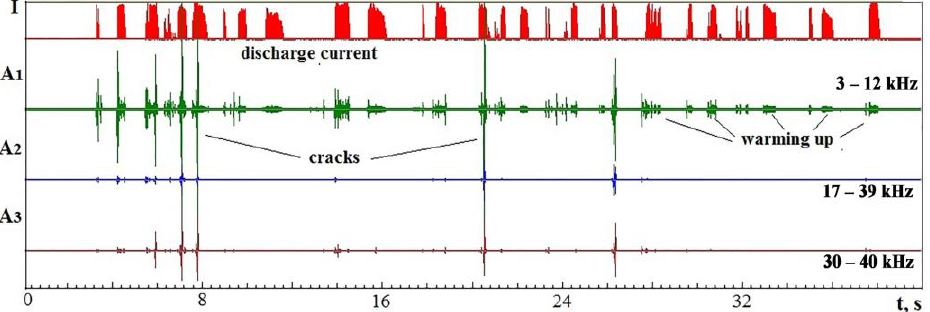
Figure 26. Records in time of the discharge current and VA signal components during electrical discharge die-sinking of IN23 ceramics.